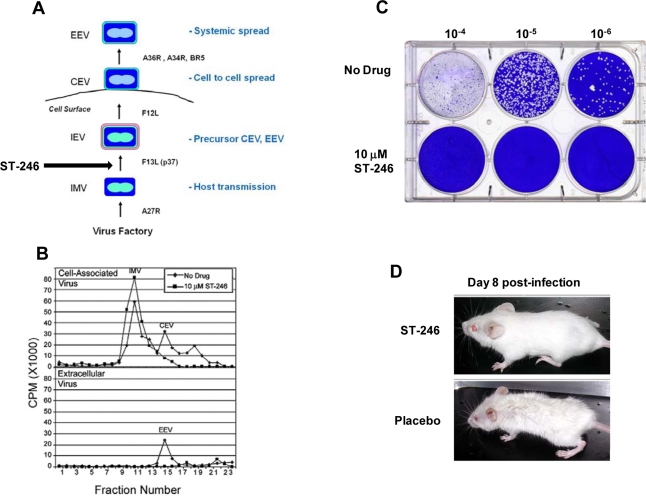
ST-246 inhibits production of extracellular virus and systemic virus spread in vitro and in vivo. (A) Diagram showing the four infectious forms of vaccinia virus and viral genes required for each step in the morphogenesis process. Vaccinia virus genes involved in each step in the pathway are shown (adapted from Smith et al. [23]). (B) ST-246 inhibits extracellular virus (CEV and EEV) formation. BSC-40 cell monolayers were infected with vaccinia virus at 5 pfu/cell in the presence and absence of 10 μM ST-246. The cell monolayers were radiolabeled with 35-S methionine and vaccinia virus particles, either cell-associated (upper graph) or released into the culture medium (lower graph) were fractionated by equilibrium centrifugation on cesium chloride gradients. The radiolabeled material in each fraction was quantified by liquid scintillation. The assignment of each type of virus particle was based upon their reported density (adapted from Chen et al.) [48] (C) ST-246 inhibits plaque formation. BSC-40 cell monolayers (1 × 106 cells/well) were infected with 10-fold serial dilutions of vaccinia virus in the presence and absence of 5 μM ST-246. At 3 days post-infection, the cultures were fixed in 5% glutaraldehyde and stained with crystal violet to visualize plaques. (D) ST-246 protects mice from systemic disease. Mice were inoculated with a lethal dose of vaccinia virus (WR) via the intranasal route. ST-246 was administered at 100 mg/kg as a liquid suspension by oral gavage once per day for 14 days. Shown are mice treated with ST-246 or placebo at day 8 post-infection.